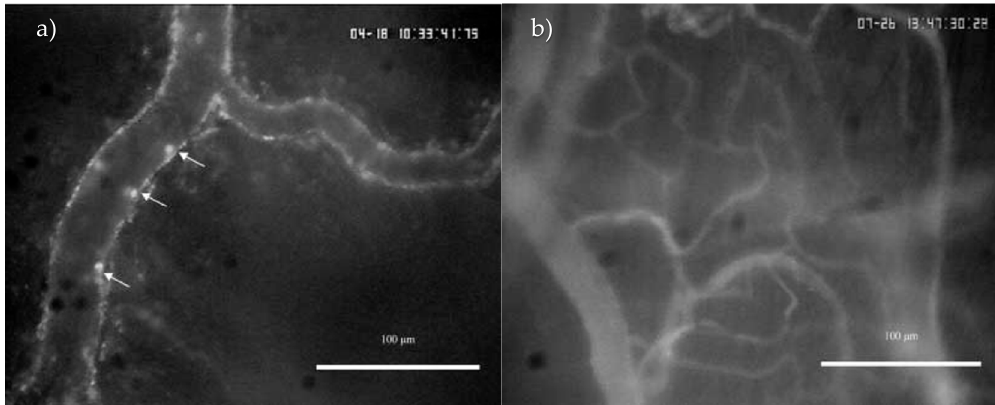
Figure 2. Still frame images from leukocyte trafficking ( a ) and capillary perfusion ( b ) videos obtained from intravital microscopy of mouse bladder (magnification = 200×). Rhodamine-6G and FITC were administered i.v into the tail vein to allow fluorescent visualization of leukocyte-endothelial interactions and capillary blood flow, respectively. White arrows indicate leukocytes interacting with the endothelium of the venule.